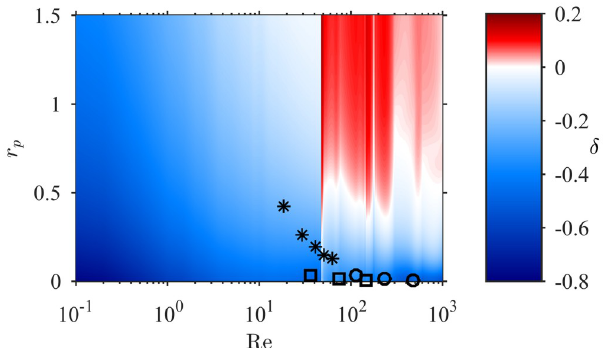
Fig 9. Numerical estimates of the exponent δ governing the dependence of contact rate on collector diameter δ ), over the entire Re- r ( CR / D p parameter space. There are regions of both δ > 0 (increasing contact rate with c collector size) and δ < 0 (decreasing contact rate with collector size). Markers represent the experimental data presented in Fig